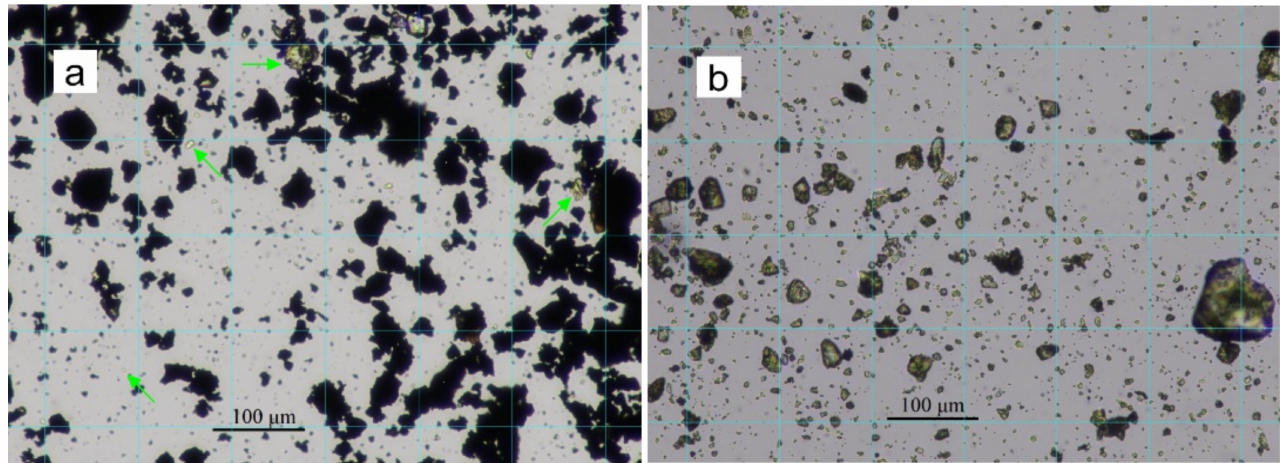
Figure 4. Dust particle size in ( a ) iron ore handling environment (near site B, Figure 1) and ( b ) in southeastern part of the city (near site E, Figure 1) ( b ). Arrows highlight non-ferrous crustal (silicate and other) minerals. Photographs were taken using microscope “Nikon Eclipse Ci-L”. The grid was added using software